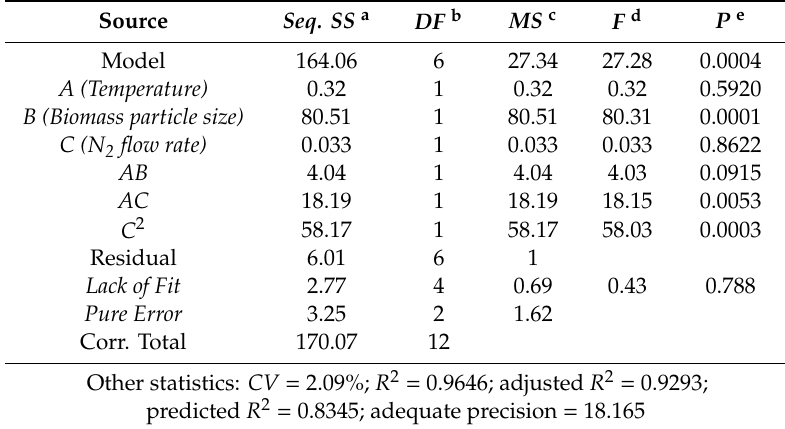
Table 3. Analysis of variance (ANOVA) for the response surface analysis of bio-oil yield from pigeon pea wood